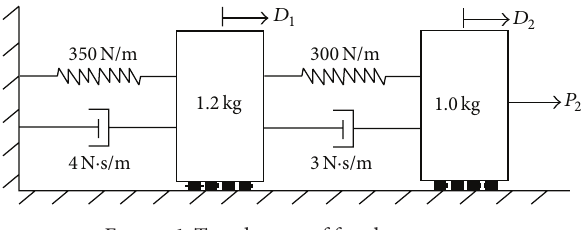
Figure 1: Two degrees of freedom system. Table 2: Suitable sensor and actuator locations. Degree of Freedom 𝜑 inv 1𝐿 𝜑 𝑘1 Optimum Control Case